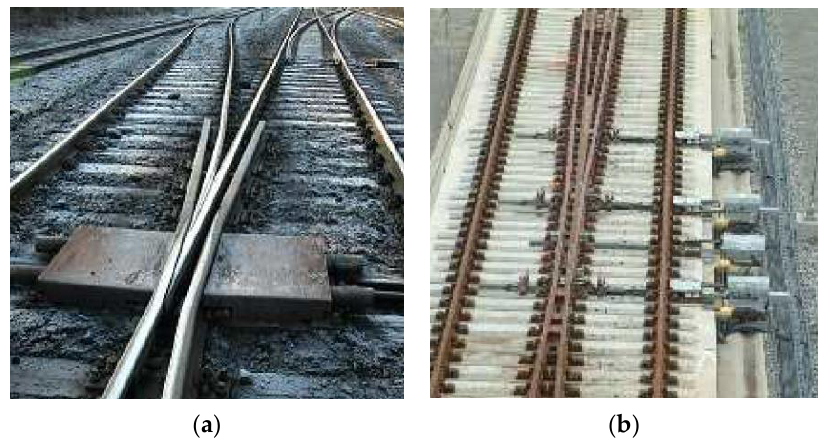
Figure 5. Examples of switches with swingnose crossing and jointless switches [2].